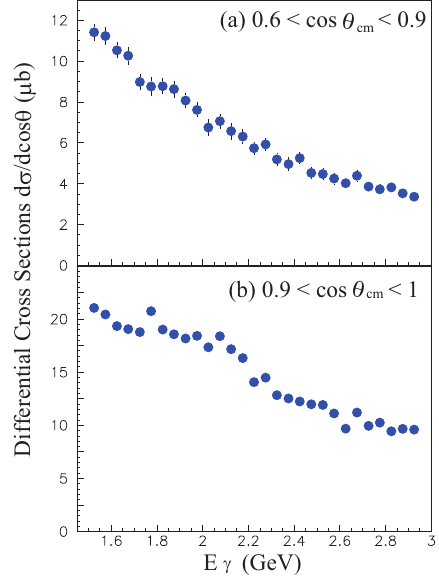
Figure 1. Di ff erential cross sections for the γ p → π + n reaction for (a) 0.6 < cos θ cm < 0.9 and (b) 0.9 < cos θ cm < 1 [22].